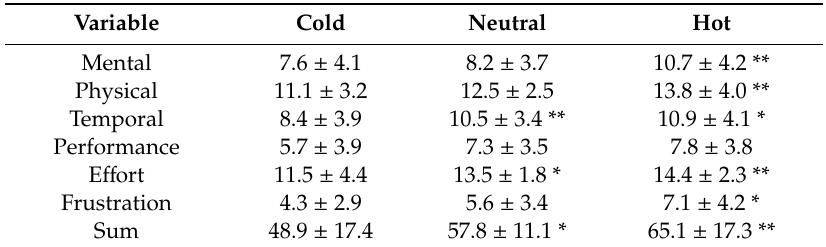
Table A1. NASA-TLX perceived